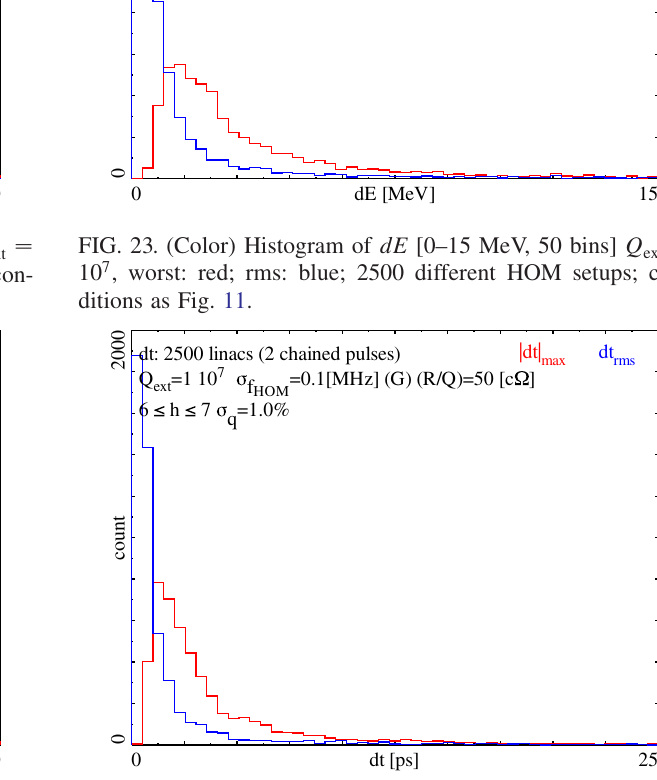
FIG. 21. (Color) Histogram of highest cavity voltages [0– 20 MV, 50 bins] for Q ext ¼ 10 8 over 2500 different HOM setups; conditions as in Fig. 8.